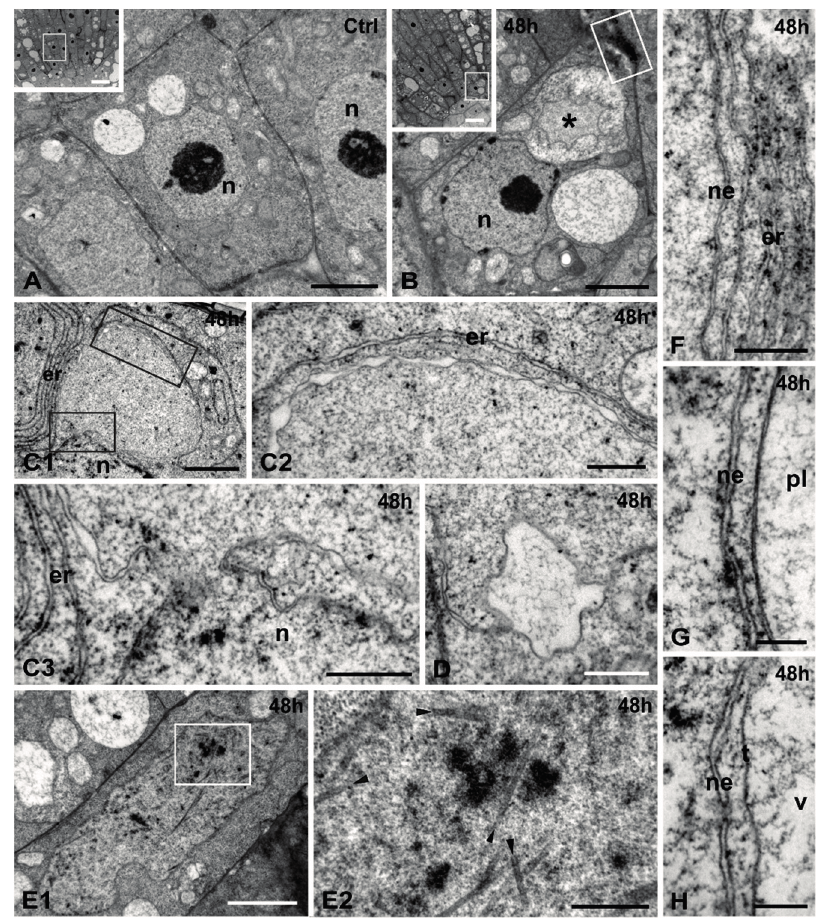
Figure 4. Cr(VI) effects on the nuclear structure and membrane integrity of A. thaliana . ( A , B ) Cells of untreated ( A ) and 48 h Cr(VI)-treated ( B ) roots, located in the apical meristematic zone (insets, outlined). Nuclei (n) have a smooth contour. In the treated cell ( B ) the nucleus (n) has a wavy contour and one vacuole collapsed ( * ). Outlined area in ( B ) is magnified in Figure 7E; ( C ) 48 h Cr(VI) treatment. Outlined areas in ( C1 ) are enlarged in ( C2 ) and ( C3 ). A bulbous outgrowth of a nucleus ( C1 ), delimited by a double membrane envelope with annulate dilations of the inter-membrane space ( C2 ). The nuclear envelope is continuous with the outgrowth membranes in the narrow connecting neck ( C3 ); ( D ) A large dilation of an outgrowth inter-membrane space containing fibrous material; ( E ) 48 h Cr(VI) treatment. Outlined area in ( E1 ) is magnified in ( E2 ); An elongate lobed nucleus ( E1 ) bearing several intranucleoplasmic tubular structures of 35–36 nm diameter ( E2 , arrowheads); ( F – H ) 48 h Cr(VI) treatment. Proximity of nuclear envelope (ne) with ER ( F , er), a plastid ( G , pl) and a vacuole ( H , v): all membranes are parallel to each other, not contacted and intact. t, tonoplast. Scale bars: Insets: 10 μ m; ( A , B , C1 , E1 ): 2 μ m; ( C2 , C3 , D , E2 ): 0.5 μ m; ( F – H ): 0.2 μ